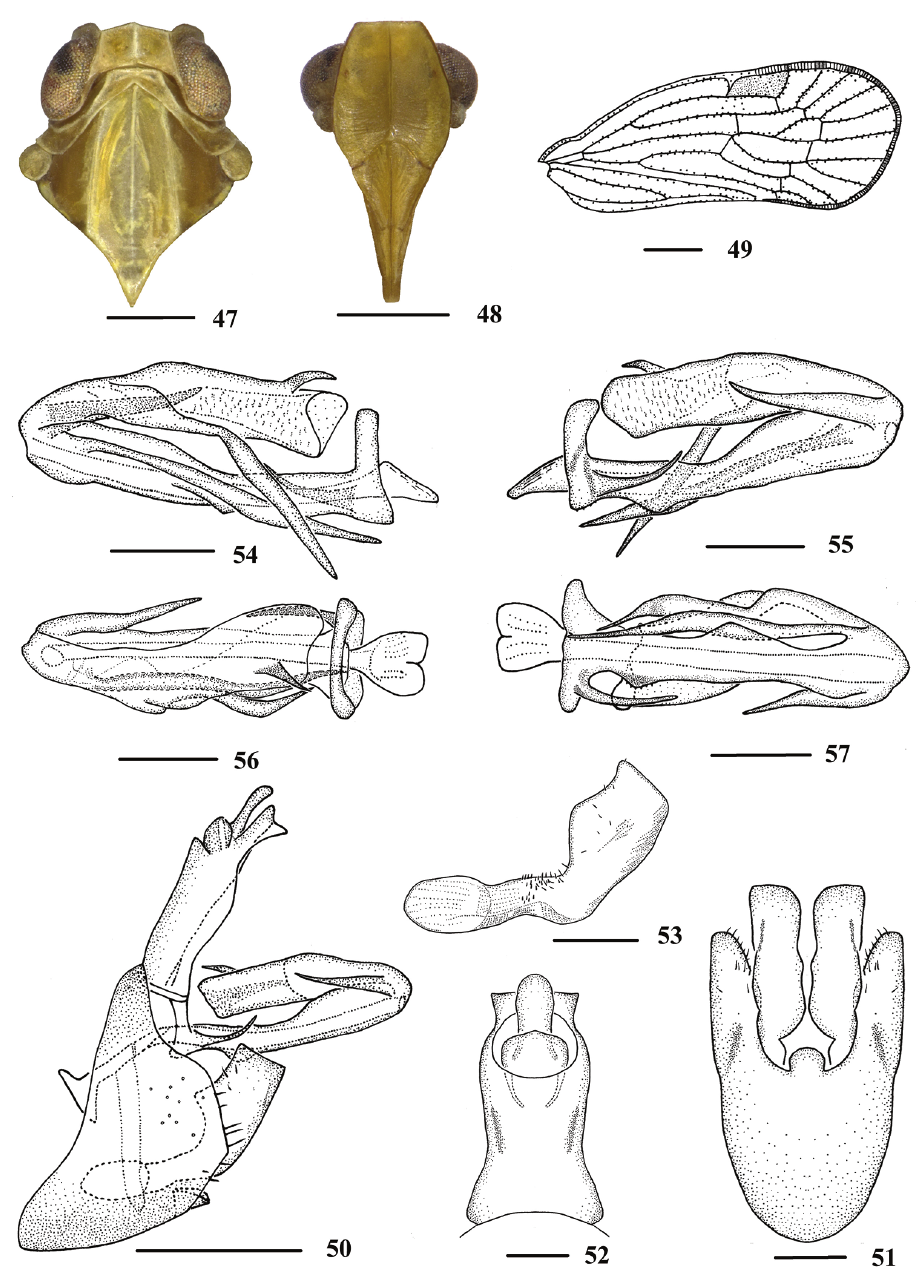
Figures 47–57. Neocarpia reversa sp. n., male 47 Head and thorax, dorsal view 48 Face, ventral view 49 Forewing 50 Genitalia, lateral view 51 Pygofer and genital styles, ventral view 52 Anal segment, dorsal view 53 Genital styles, inner lateral view 54 Aedeagus, right side 55 Aedeagus, left side 56 Aedeagus, dorsal view 57 Aedeagus, ventral view. Scale bars: 0.5 mm ( 47–48, 50 ); 1.0 mm ( 49 ); 0.2 mm ( 51–57